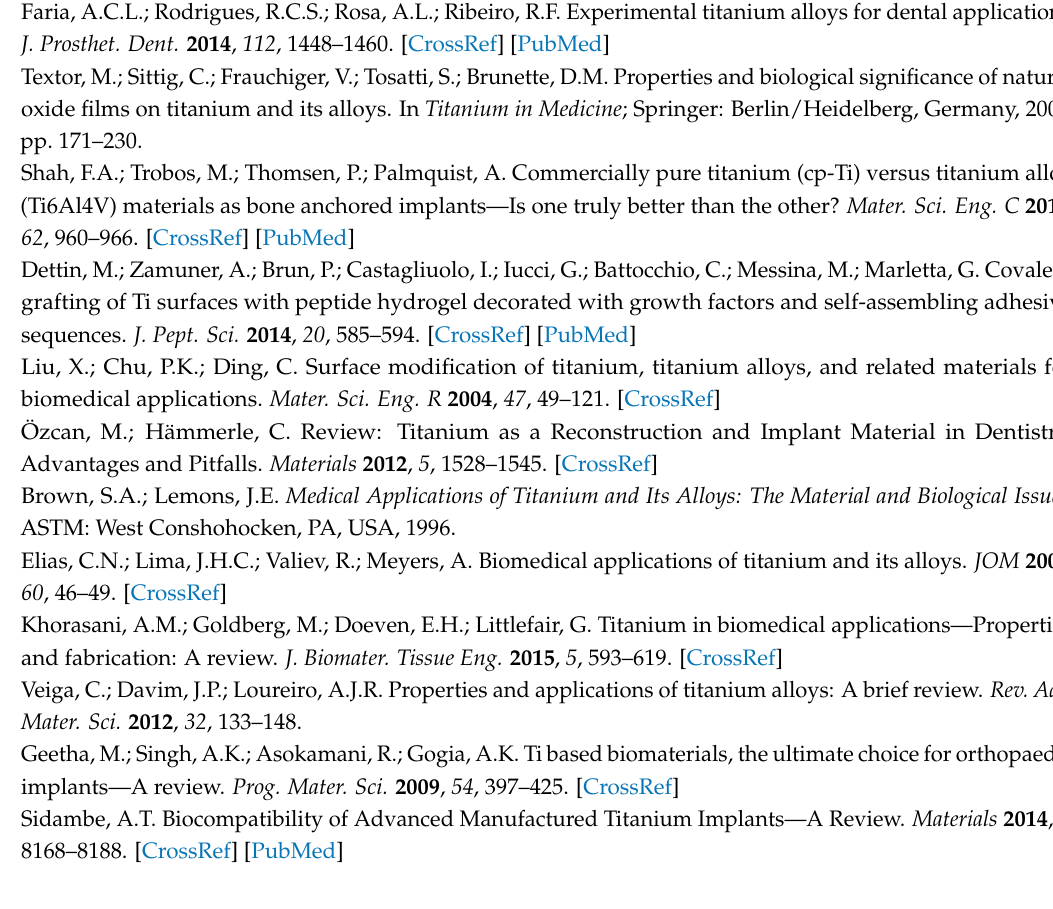
Figure S1: Total EDS mapping spectrum and relative distribution of the concentration of each constituent element on the Ti25Nb10Zr alloy surface performed in a one scanned zone on the surface, Figure S2: AFM image of Clean Surface Sample, Table S1: The elemental composition of the alloy determined by EDS measurements, Table S2: Binding Energies in eV of the atomic species present on the Clean Surface Sample and the relative atomic ratios, Table S3: Binding Energies in eV of the atomic species present on the MUL sample surface, Table S4: Binding Energies in eV of the atomic species present on the ML sample